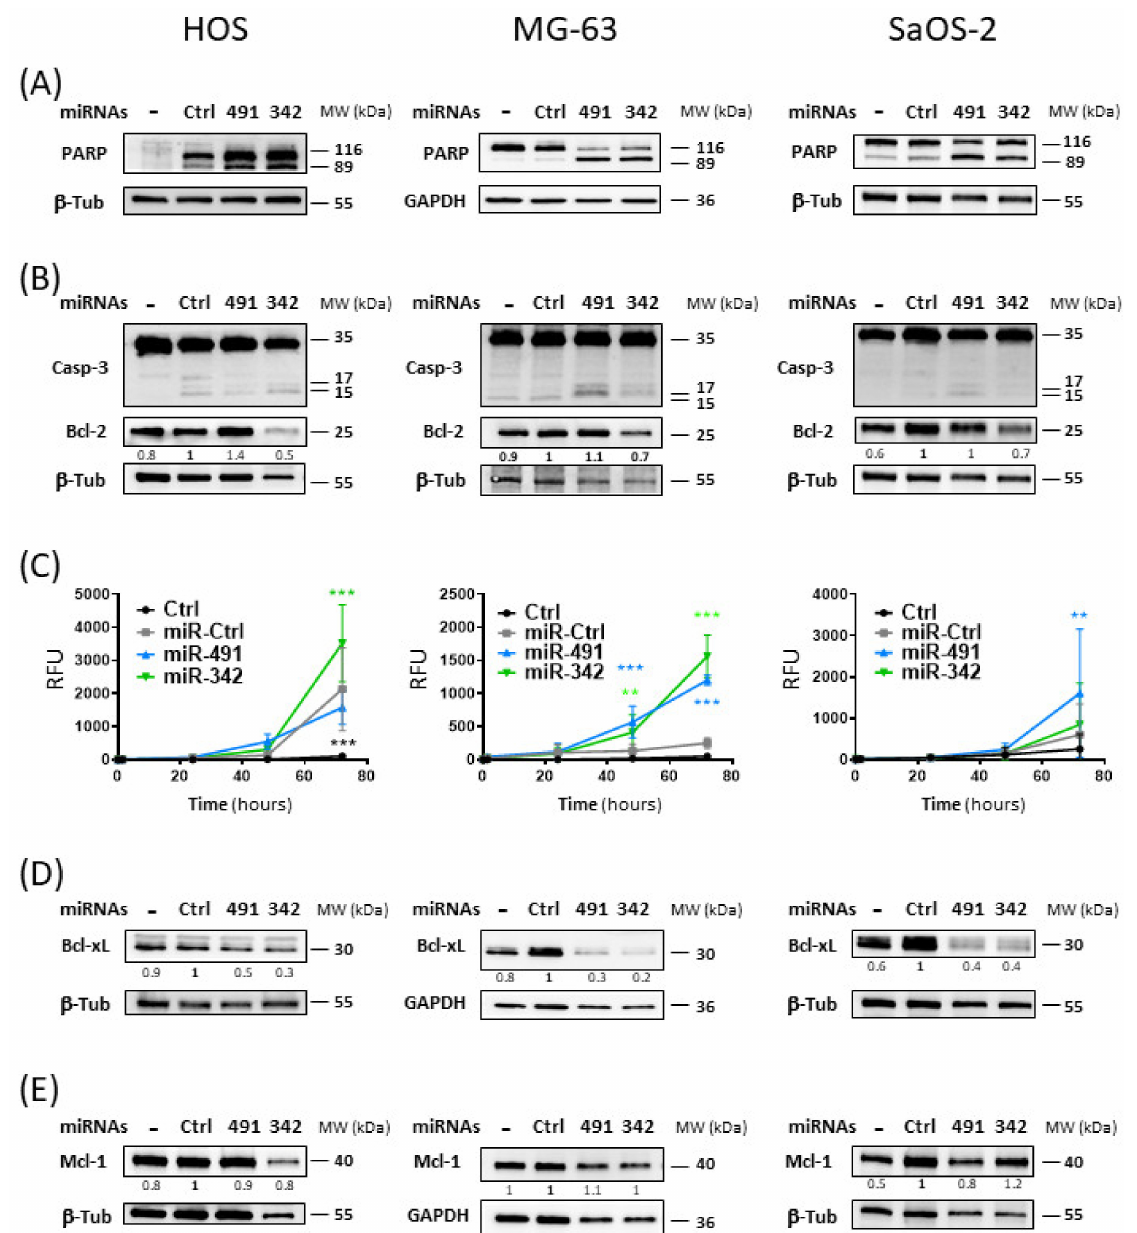
also enhanced the cleavage of caspase-3 (Figure 4B) and induced caspase-3/7 activities (Figure 4C) to different extents, depending on the cell line.